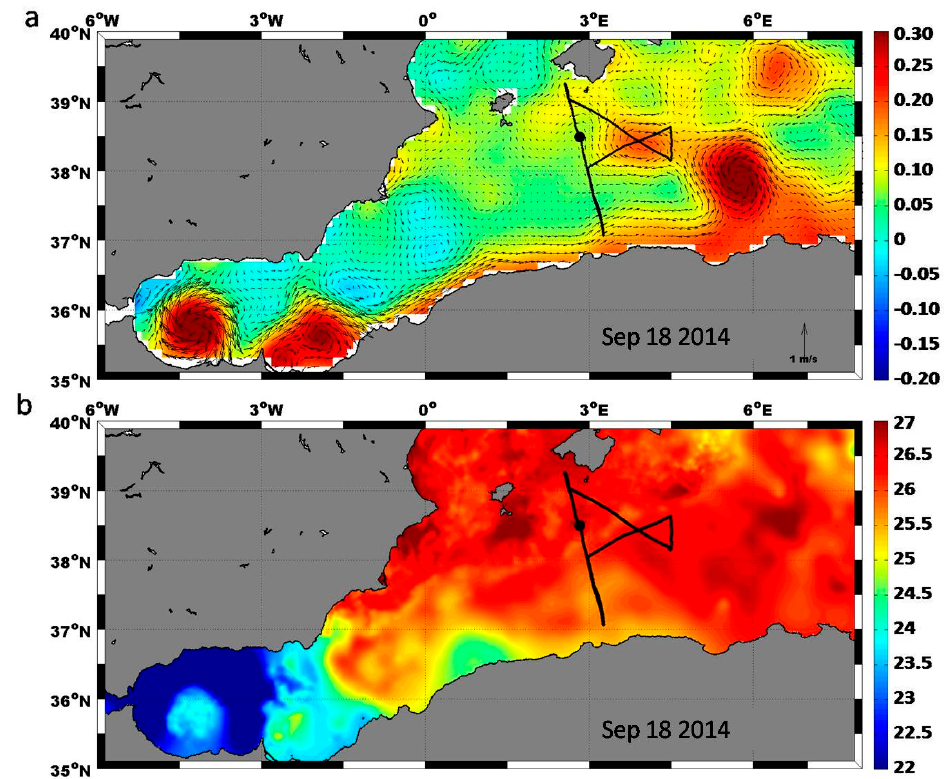
Figure 7. ( a ) All-sat-merged AVISO ADT and ( b ) ultra-high-resolution SST maps of the Alboran Sea and the Algerian Basin on 18 September 2014; geostrophic currents are represented through black arrows. Glider track in black. Large black dots represent glider location on each date. ADT in meters, SST in °C.